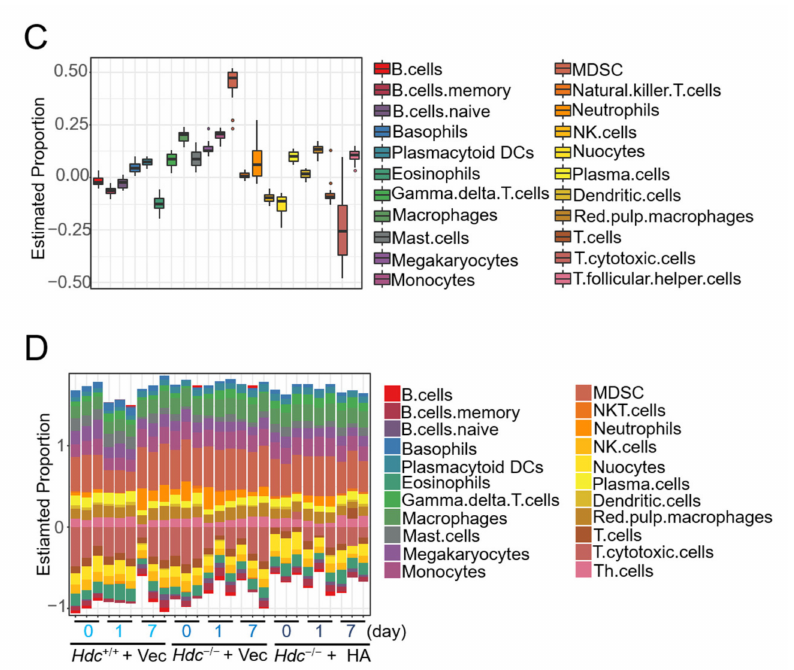
Figure 5. Infiltrated immunocytes in hearts from mice with different treatments. ( A ) Heatmap of the immunocytes in each group. ( B ) Correlation of the heatmaps of all the immunocytes. The color of the small squares represents Pearson’s correlation coefficient between the two immunocytes on the horizontal and vertical coordinates, and the blue to red gradient shows the coefficients from low to high values. (C and D) Summary of the estimated immune scores ( C ) and estimated fractions ( D ) of 22 subtypes of immunocytes from the ssGSEA algorithm in all groups. Each bar chart exhibits the cell proportions of each samples and the various colors represent the 22 immunocytes with annotations beside the legend.